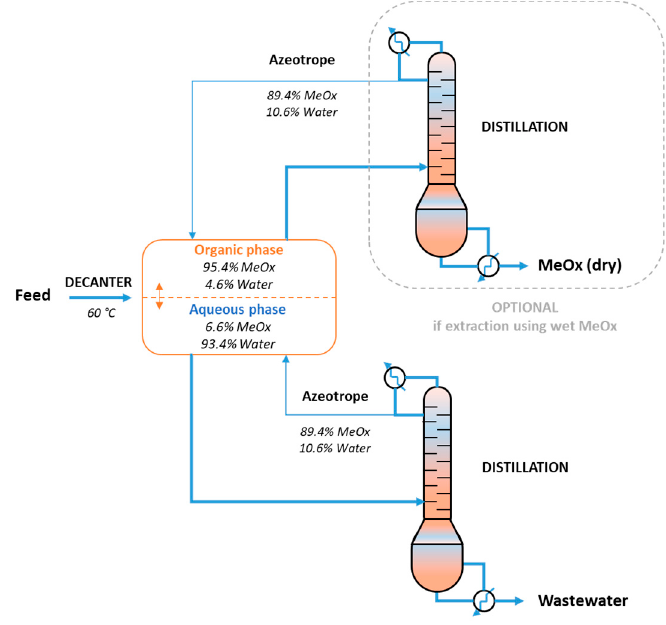
Figure 8. Dry 2-MeOx recovery process.